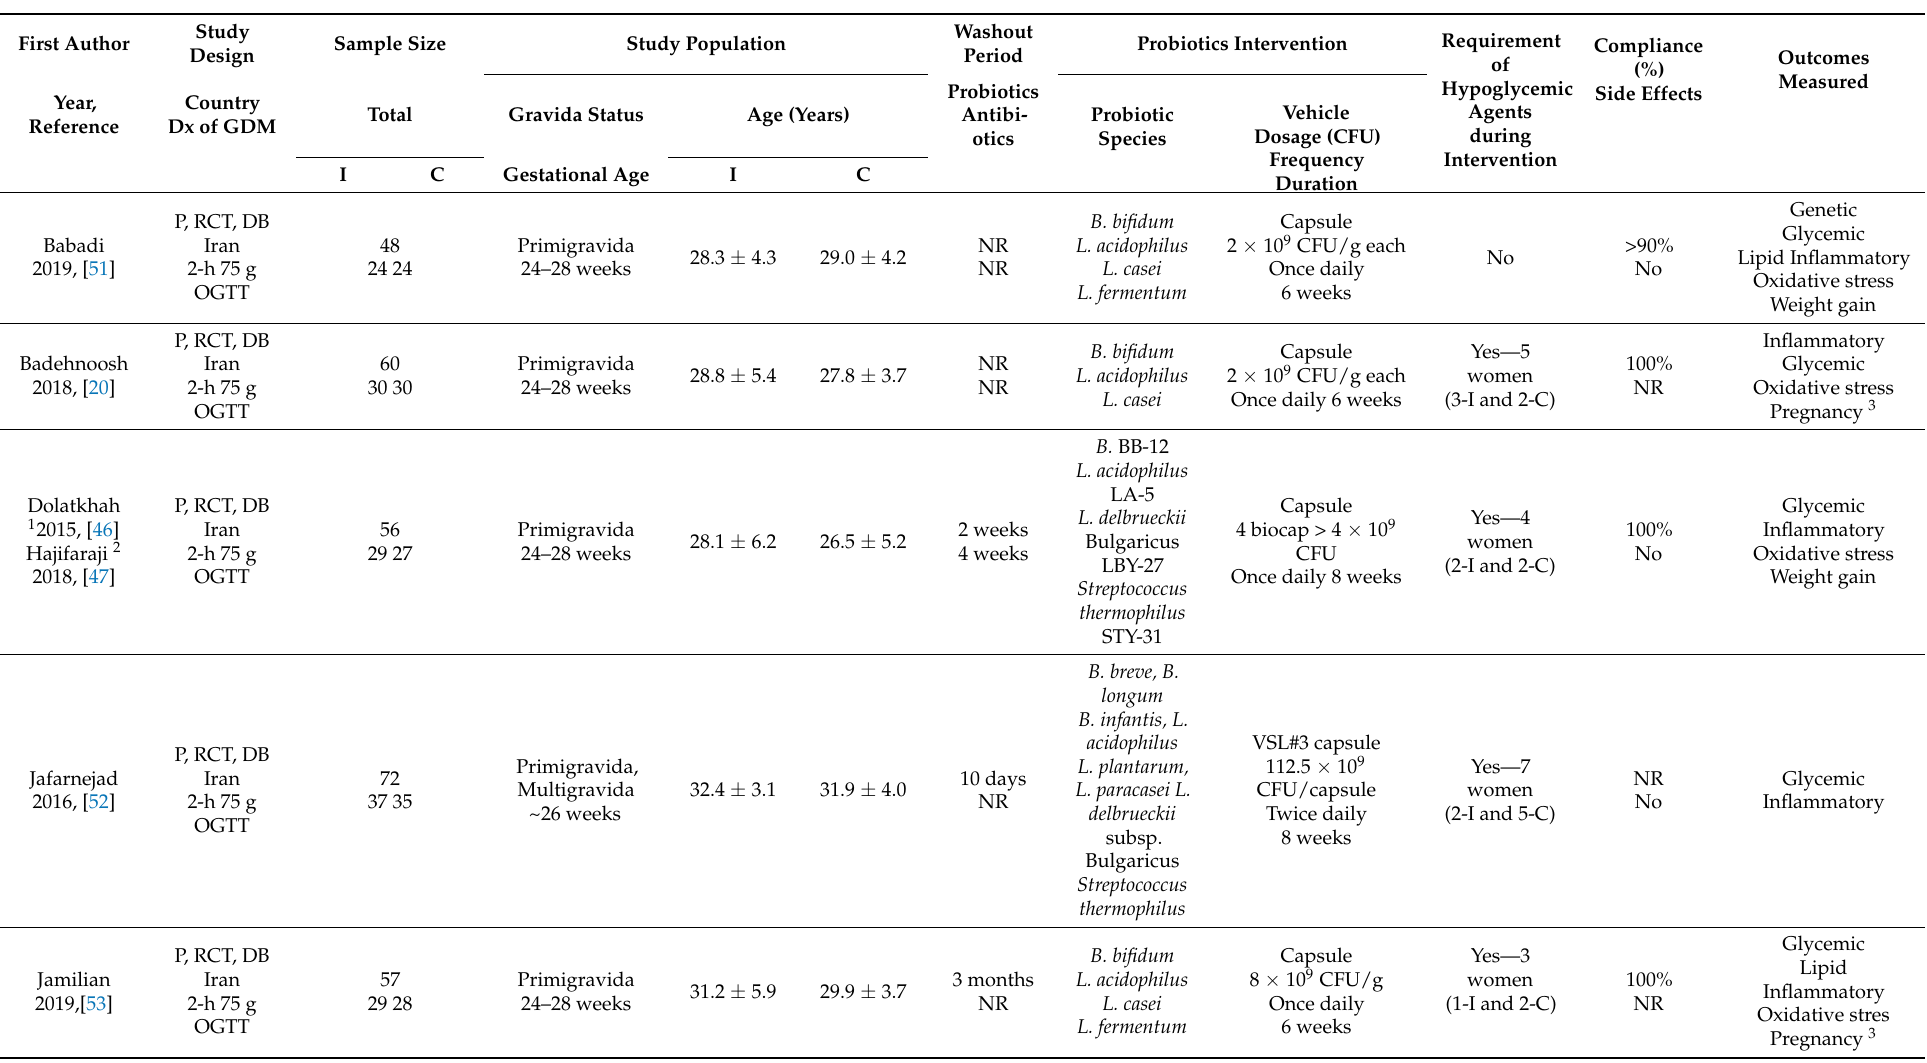
Table 1. Characteristics of randomized control trials included in this